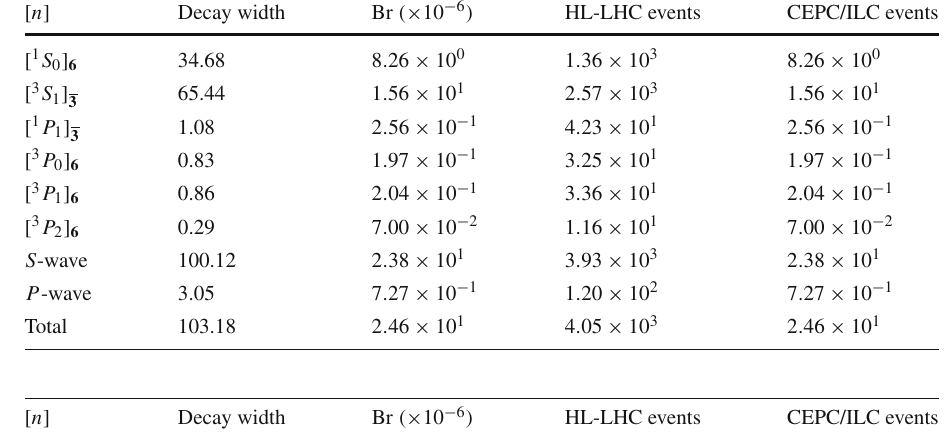
Table 2 Decay widths ( × 10 − 9 GeV), branching ratios (Br), and produced events at HL-LHC and CEPC/ILC for P -wave and S -wave (cid:2)